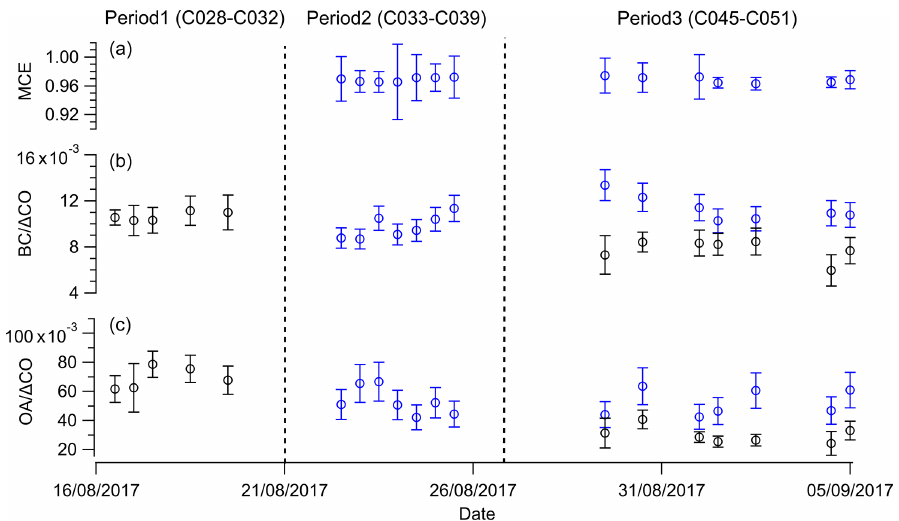
Figure 5. (a) The calculated MCE of CLARIFY FT smoke plumes for each flight. The error bars show the uncertainty. (b, c) The calculated BC /(cid:49) CO and OA /(cid:49) CO in FT and BL smoke plumes respectively for each flight. The blue markers and error bars represent the fitted slopes and uncertainty in the FT; the black markers and errors represent the average and standard deviation of calculated ratios in the BL.